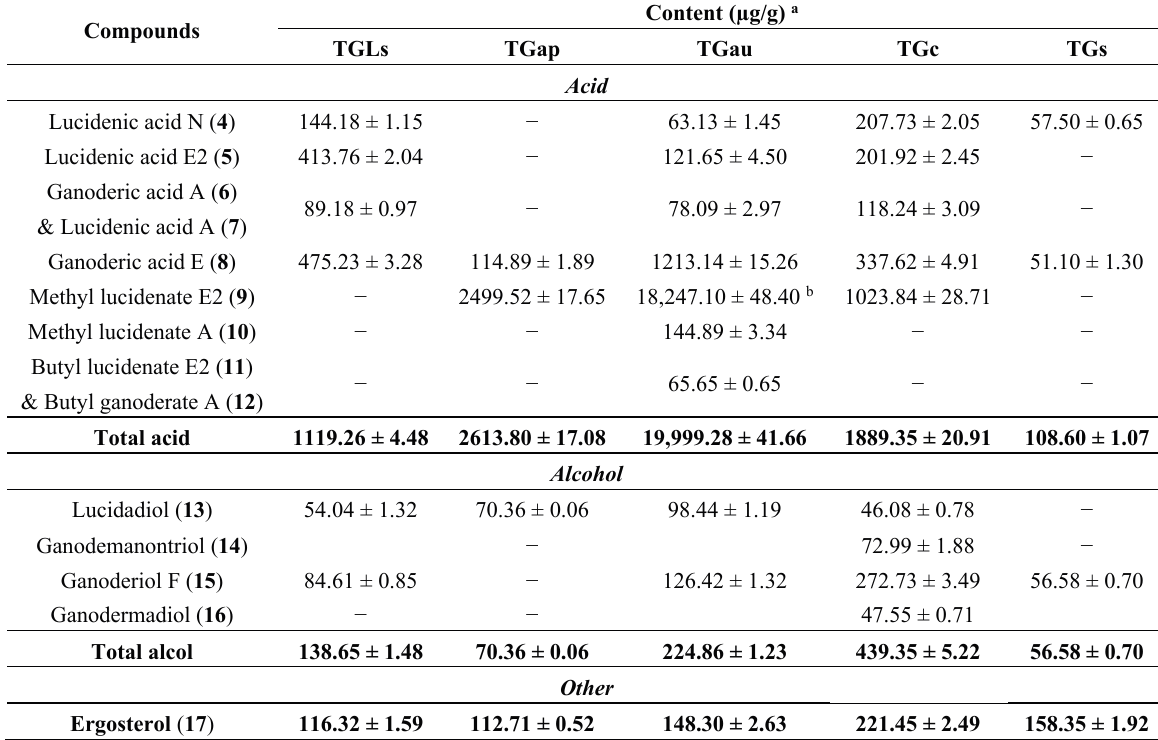
Table 6. Contents of 4–17 in the related Linzhi samples (Group